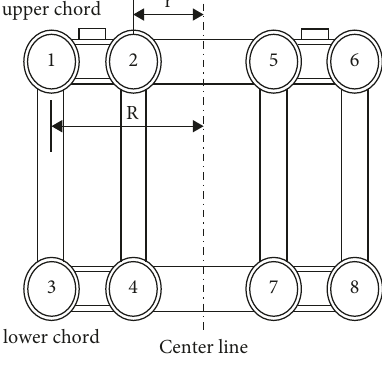
Figure 18: Chord